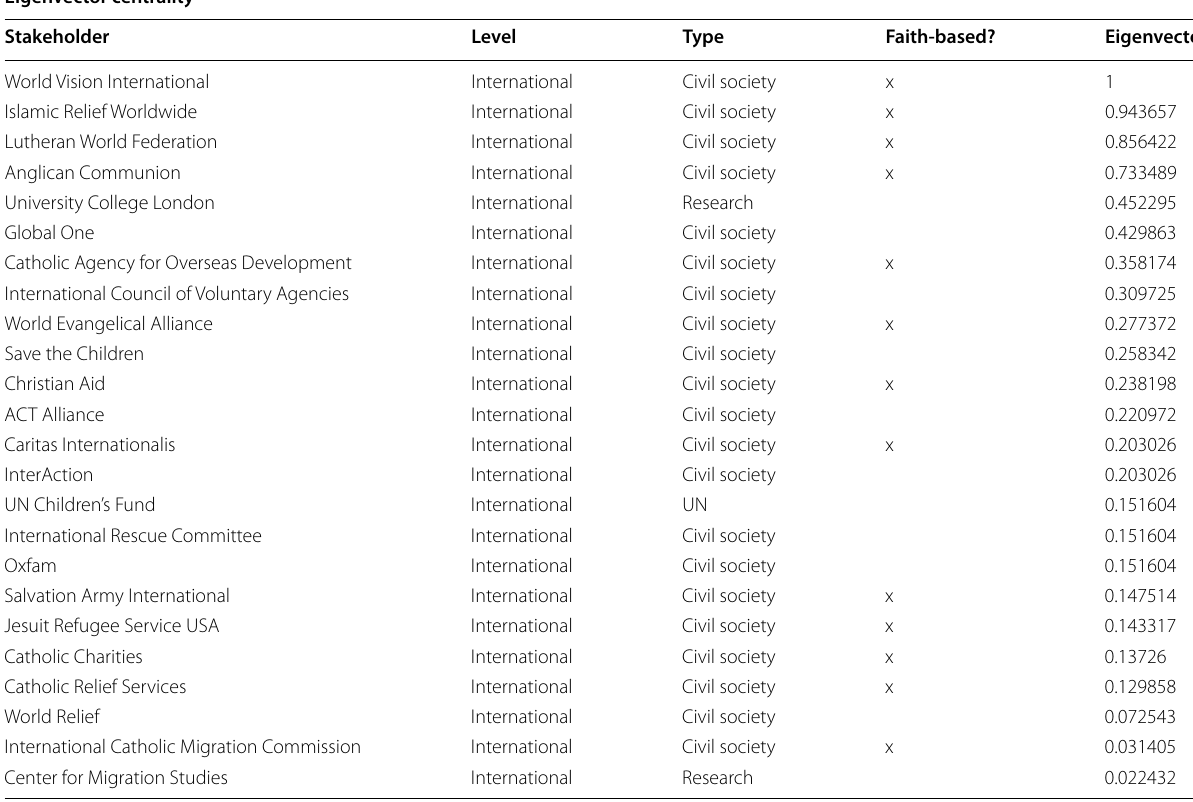
Table 4 Eigenvector centralities of identified stakeholders Eigenvector